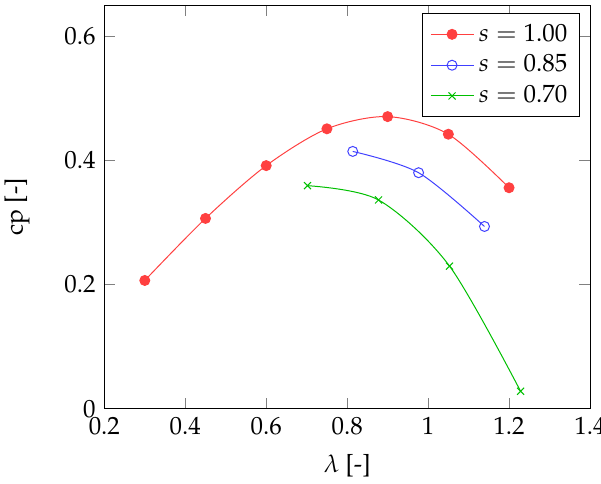
Figure 17. Characteristic curves for different blade